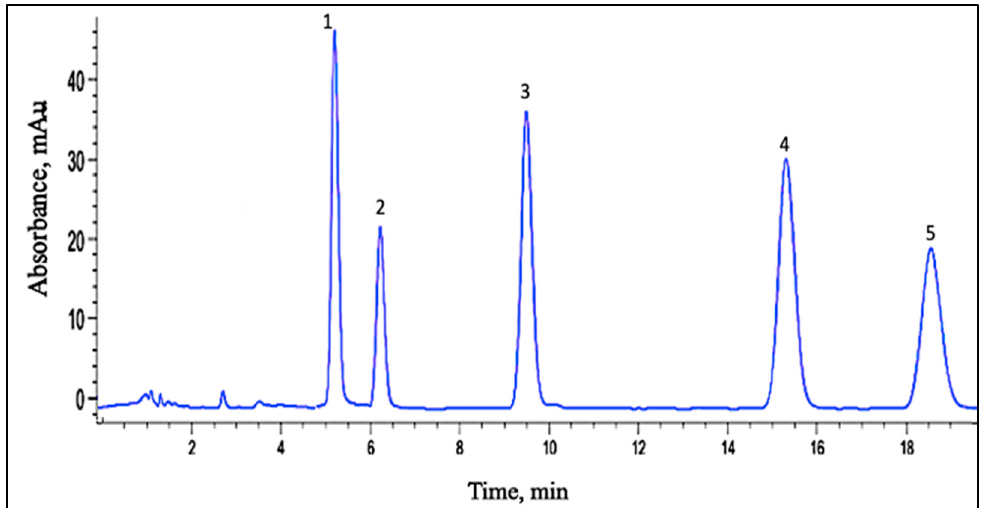
Figure 4. Chromatogram of BZDs mixture at the optimal conditions of mobile phase containing 50% of 20 mmol L − 1 phosphate buffer at pH = 7 and 50% methanol, flow rate at 1.0 mL min − 1 , a wavelength at 214 nm and 40 °C column temperature. BZDs mixture: 1-Bromazepam (170 ng mL − 1 ), 2-Clonazepam (100 ng mL − 1 ), 3-Lorazepam (130 ng mL − 1 ), 4-Nordaizepam (160 ng mL − 1 ) and 5-Diazepam (130 ng mL − 1 ).